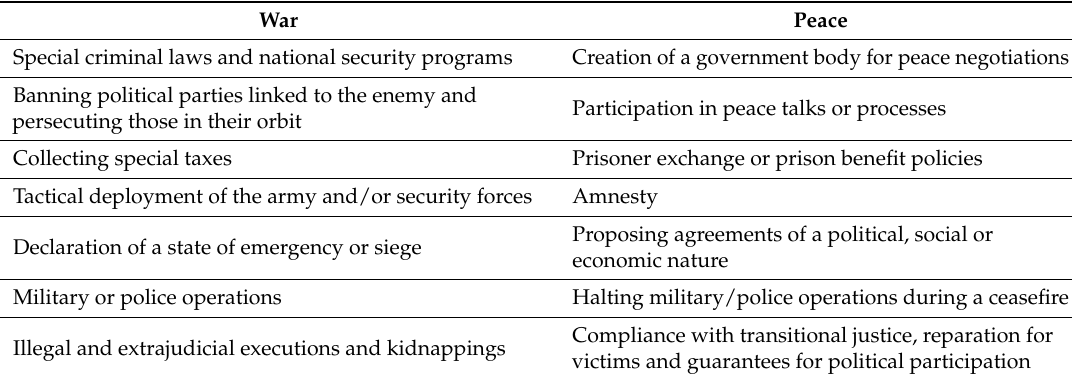
Table 4. War and peace